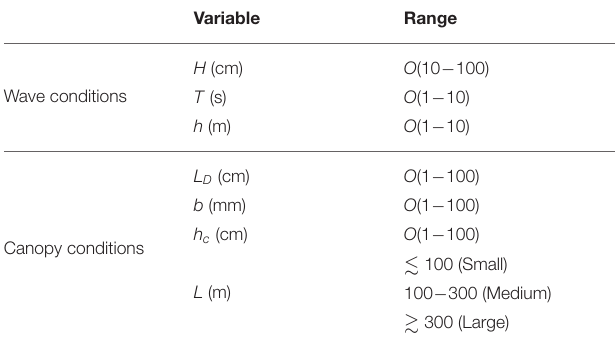
TABLE 1 | Typical wave and canopy conditions in coastal systems (Cambridge and Kuo, 1979; Kendrick et al., 2005; Infantes et al., 2009; Mohring and Rule, 2014; Oreska et al.,